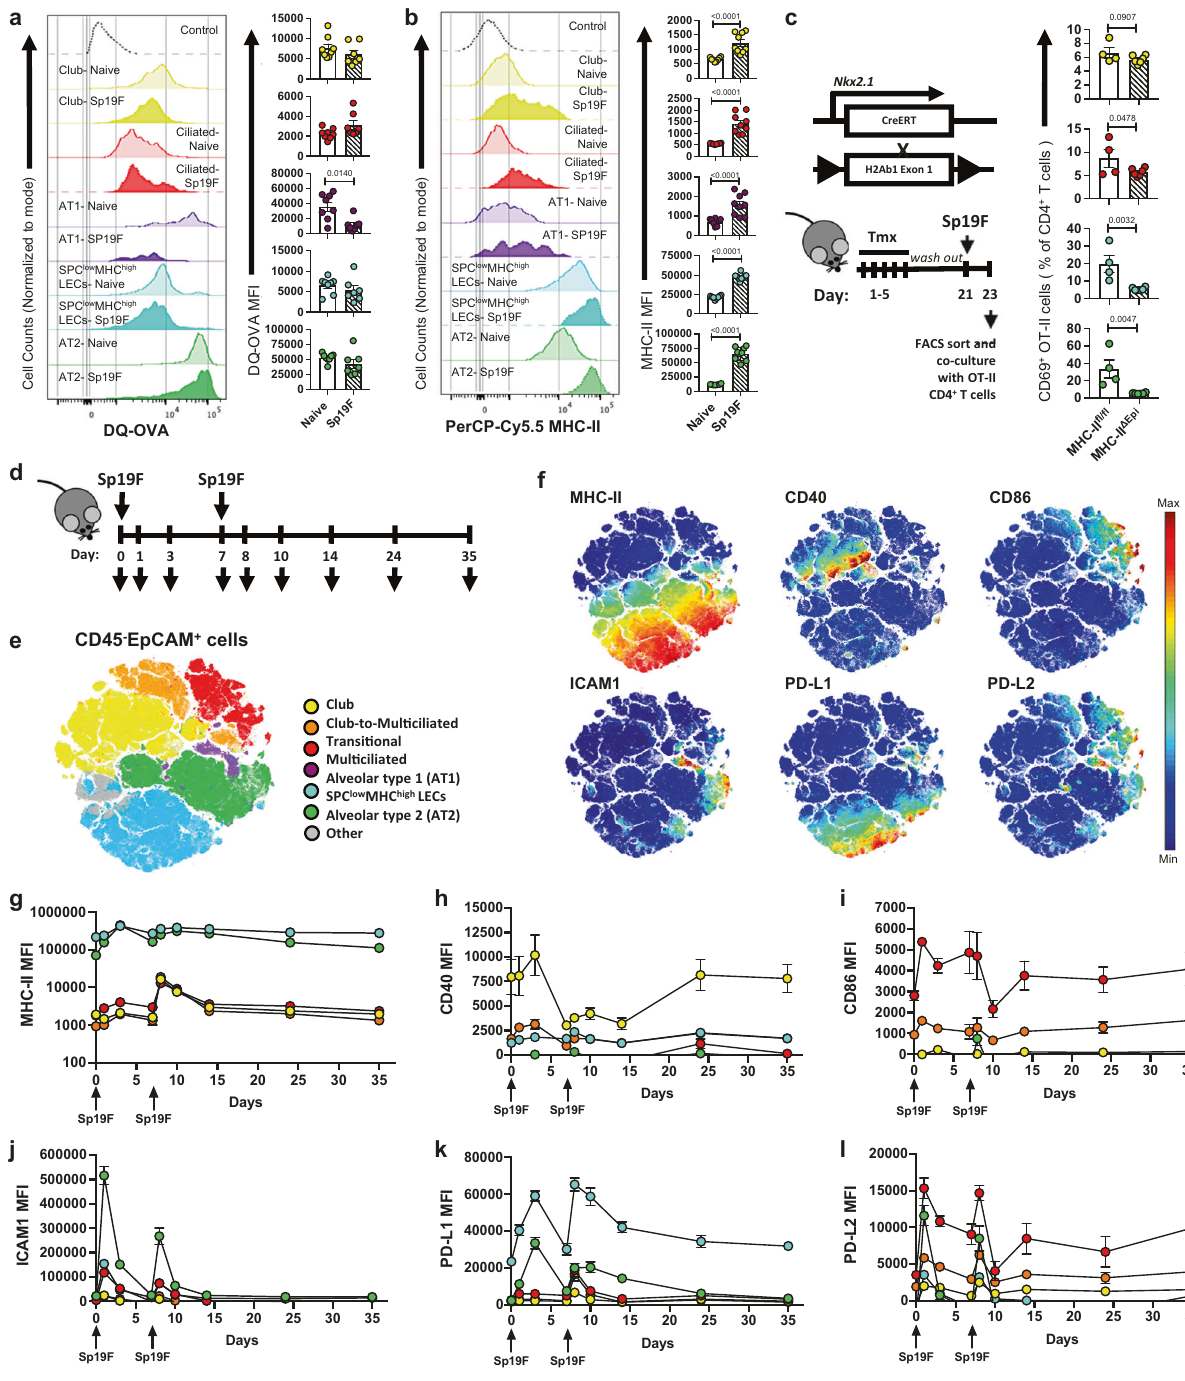
Fig. 2 LECs display anatomically segregated and temporally-dynamic APC activity. a Histogram and quanti fi cation of in vivo DQ-ovalbumin (DQ-OVA) uptake and processing abilities of LECs from naïve and Sp19F-infected mice 48hours postinfection (hpi), two-tailed Mann – Whitney test. b Histogram and quanti fi cation for LEC MHC-II from naïve and Sp19F-infected mice 48hpi, two-tailed Mann – Whitney test. c Genetic construct and experimental timeline of MHC-II Δ Epi mice. Quanti fi cation of OT-II CD4 + T cell activation by MHC-II fl / fl and MHC-II Δ Epi LECs sorted from Sp19F-infected mice 48 h postinfection (hpi), one-tailed Unpaired t test. Sorting strategy in Supplementary Figure. 2c. Note, different scales for Y-axes in Fig. 2a – c highlight that all LECs are capable of antigen presentation albeit in different amplitudes based on their anatomical location. d Schematic of experimental timeline. e opt-SNE plot depicting 6 LEC metaclusters identi fi ed from ~2 million LECs isolated from n = 84 mice across nine timepoints each with two independent experiments. f Heat map depiction for expression of APC-related molecules mapped onto opt-SNE projection. Temporal quanti fi cation for g MHC-II, h CD40, i . CD86, j ICAM1, k PD-L1, and l PD-L2 across distinct LECs. Two- Way ANOVA with Fisher ’ s LSD test statistics for Fig. 2g – l are provided in Supplementary Table 1- 6. All data have n ≥ 4 mice, two independent experiments. All data are presented as mean ±